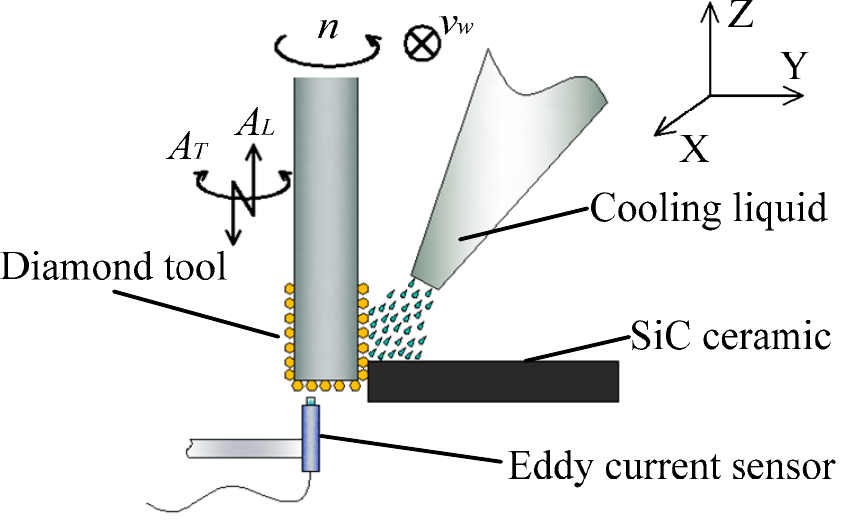
Figure 3. Schematic of the apparatus.